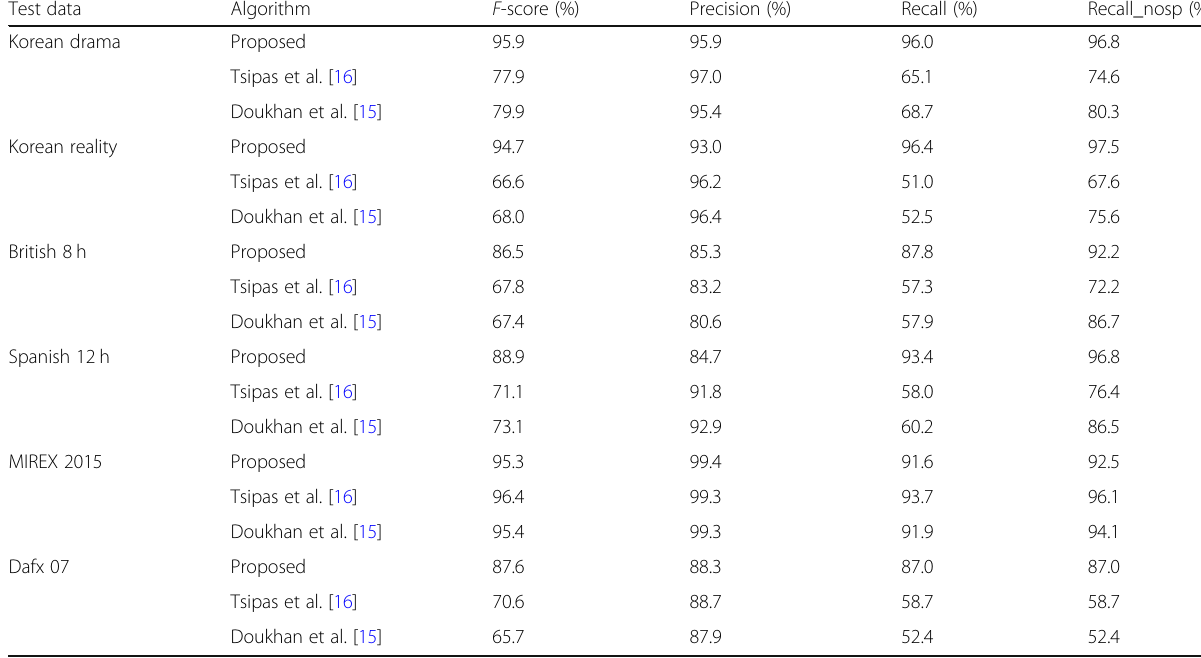
Table 5 Performance of the proposed and other discrimination algorithms Test